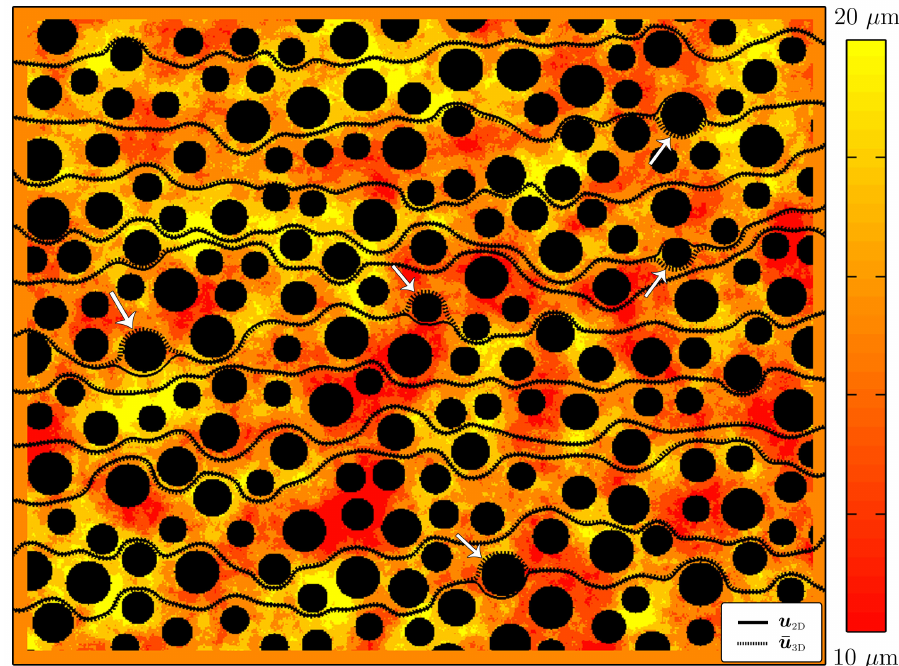
( x, y ) and ¯ u ( x, y ) in a heterogeneous pore geometry. Aperture Figure 6. Streamlines of u 2D 3D is a spatially-correlated random field between 10 and 20 µ m, shown as color map, with an aperture covariance range of θ ≈ 0 . 09 (as a fraction of the geometry’s length). Arrows indicate locations where streamlines diverge around